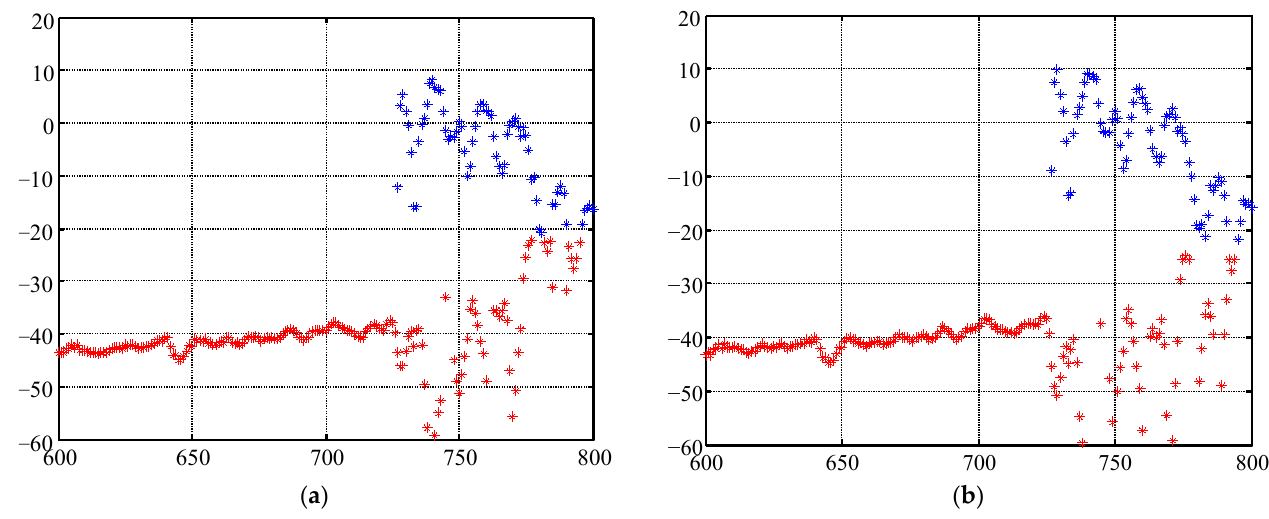
Figure 9. Height distribution of scattering points. ( a ) Multi-look compressive sensing method; ( b ) Separable approximate sparse reconstruction algorithm. The horizontal axes represent pixels from 600 to 800 in the slant range, and the vertical axes are heights in the elevation direction with the unit m.